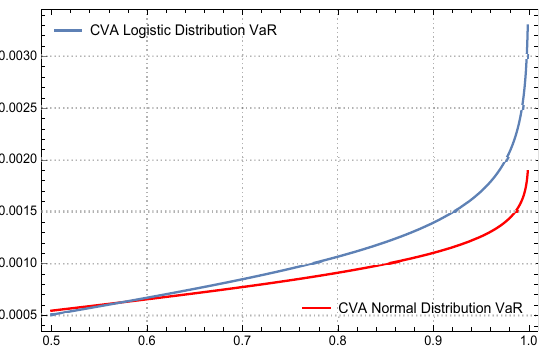
Figure 5. The CVA VaR under the logistic distribution for α ∈ [ 0.5,0.999 ] compared to CVA VaR under the normal